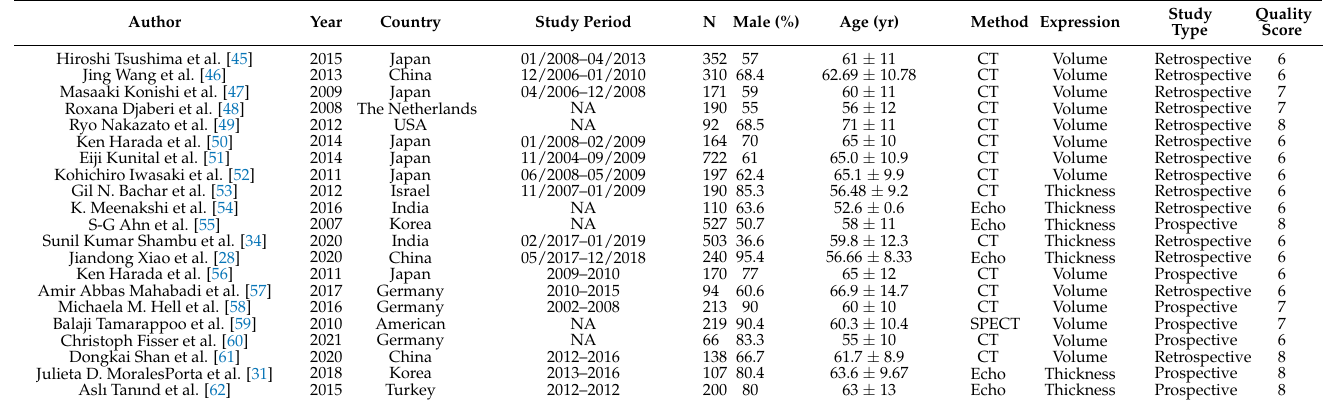
Figure 1. Flow chart of study selection in the meta-analysis. Table 1. Characteristics of included studies in the